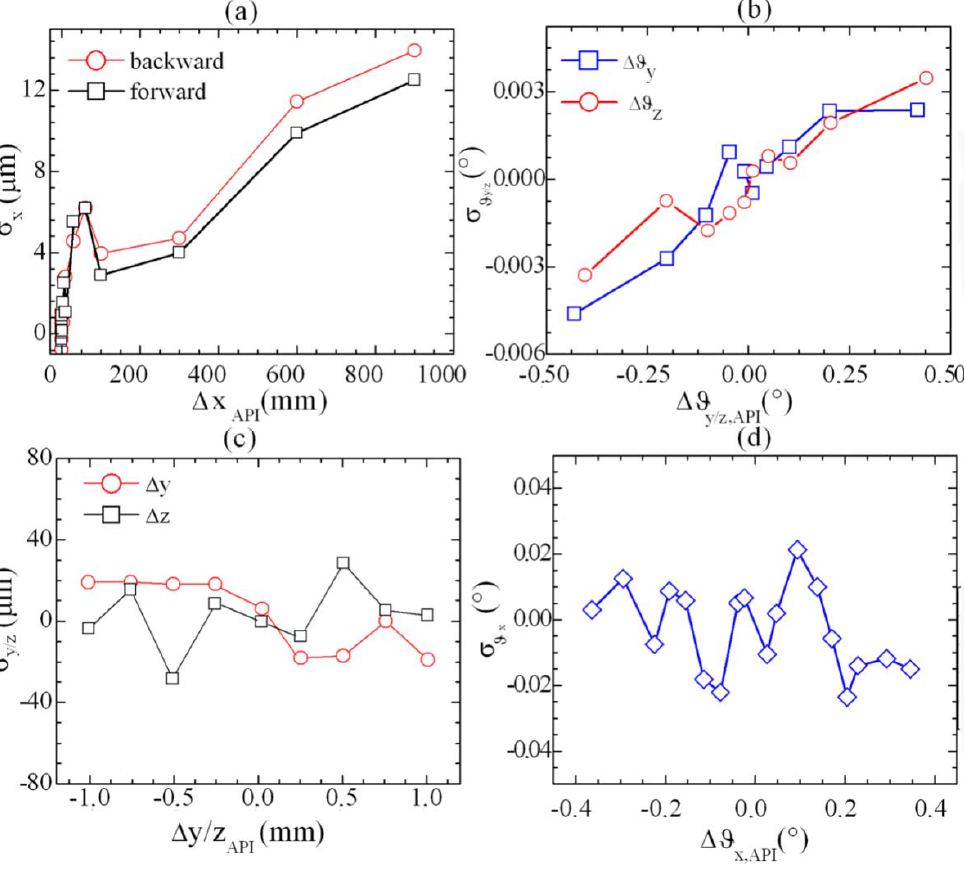
Figure 11. Measurement error for (a) linear displacement, (b) yaw and pitch rotations, (c) transverse displacement, and (d) roll rotations. The theoretical accuracy estimated for the maximum displacements performed is approximately 11  m for linear displacement,  70  m for transverse displacement,  3  10 -3 ° for yaw and pitch, and  5  10 -2 ° for